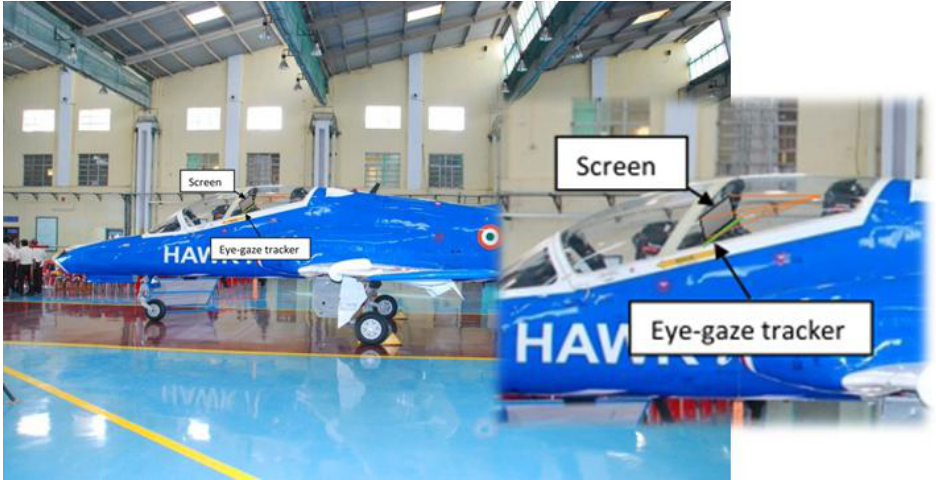
Figure 39. Testing with a Hawk trainer aircraft.